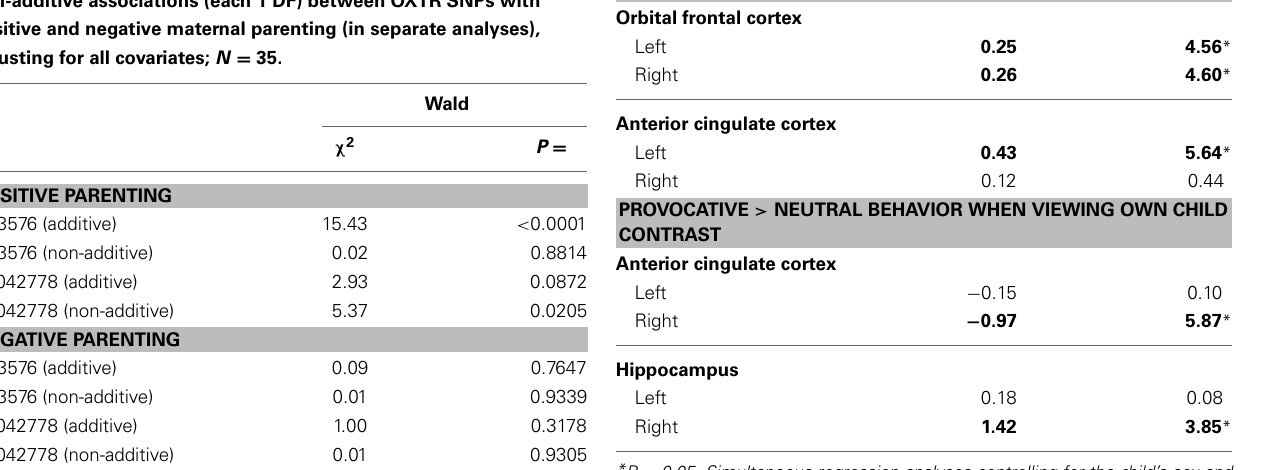
vasopressin genotypes, and for observed maternal parenting, presented by oxytocin receptor gene (OXTR) rs53576 genotypes. To facilitate interpretation, all variables on y axes are expressed as sample z-scores (mean = 0; standard deviation =